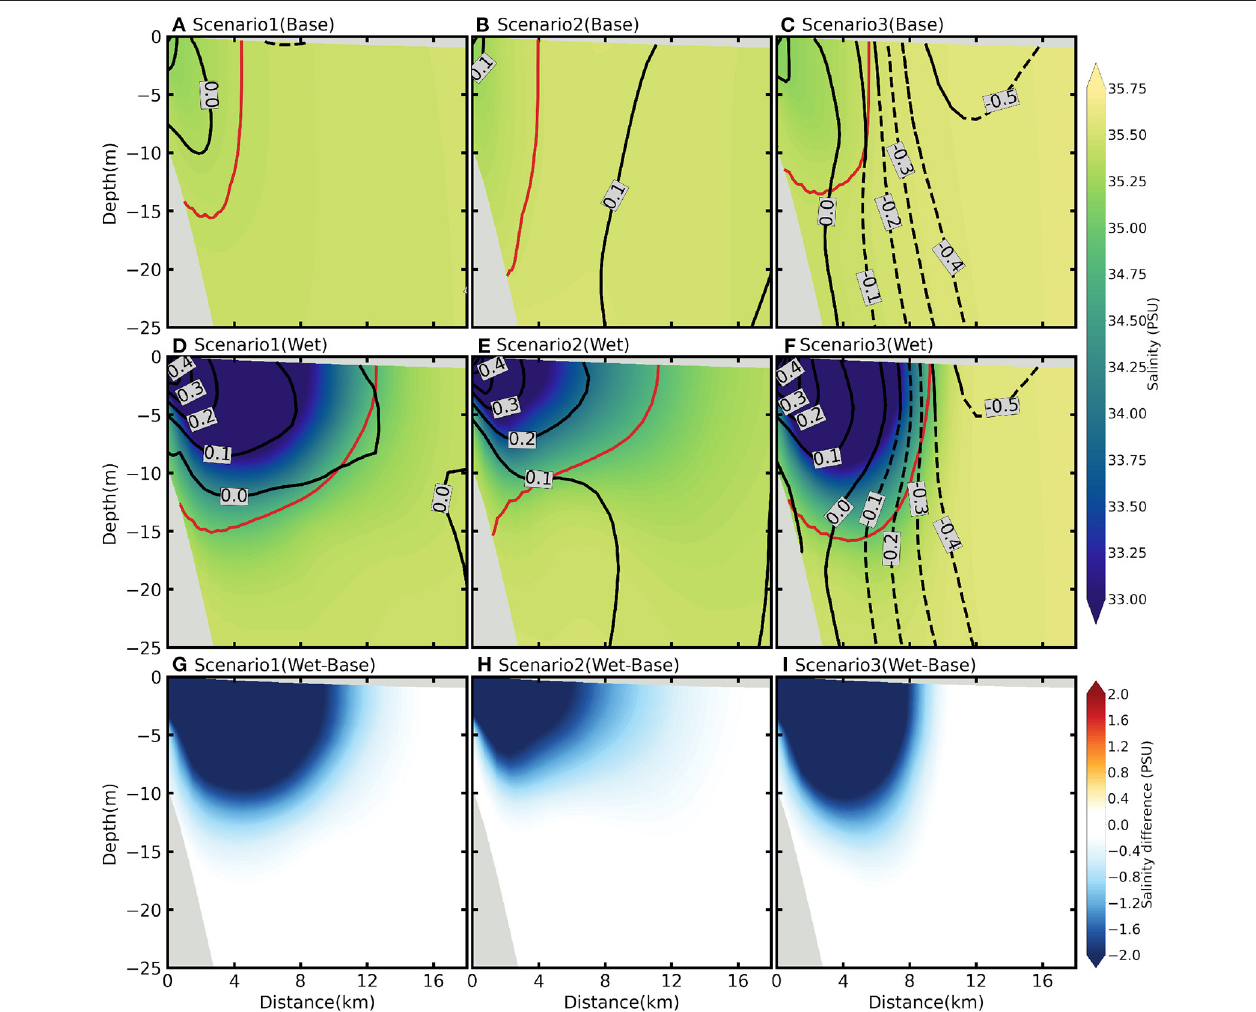
FIGURE 8 | Cross-section profiles of salinity averaged over the first 4 days within the purple box in Figure 6 for each EAC scenario and their differences between the wet event and the base case. (A–C) Cross-section profile of salinity for EAC scenario 1, EAC scenario 2, and EAC scenario 3 in the base case. The solid and dashed black lines show the eastward and westward velocities, respectively. The red line indicates the contour of 0.15 dye concentration. (D–F) Same as (A–C) , but for the wet event. (G–I) Differences of salinity for three EAC scenarios between the wet event (D–F) and the base case (A–C) . Only the salinity profiles less than 18 km from the river mouth are